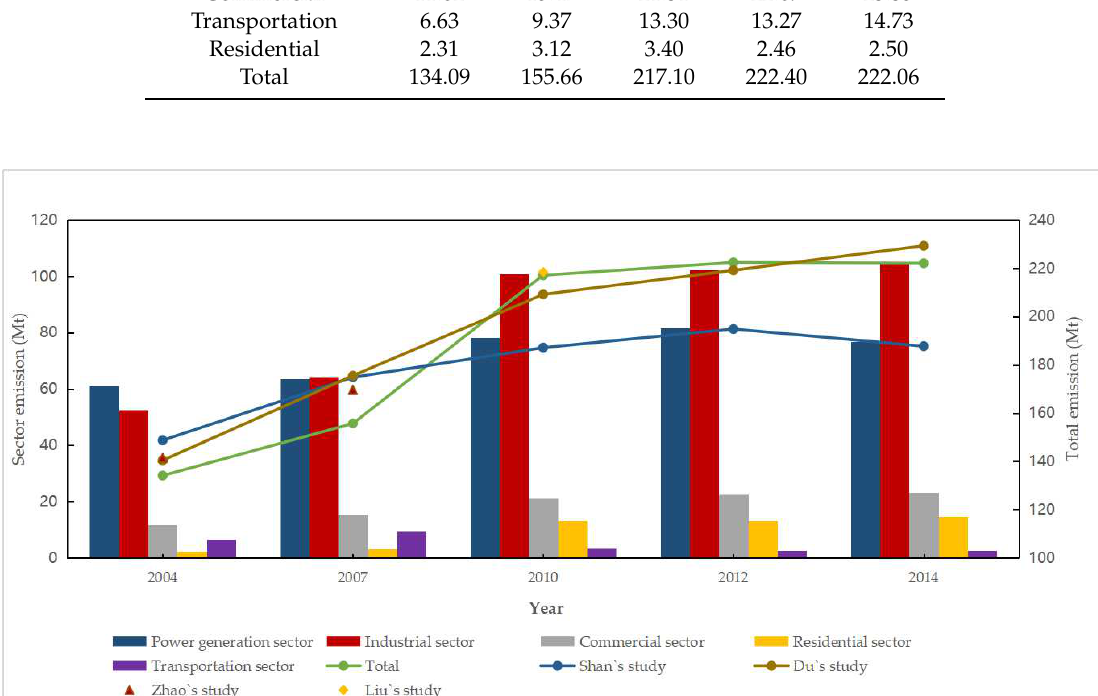
Figure 4. CO 2 emission comparison of different sources. Data source: emission estimated by Shan`s Figure 4. CO ff erent sources. Data source: emission estimated by 2 emission comparison of di